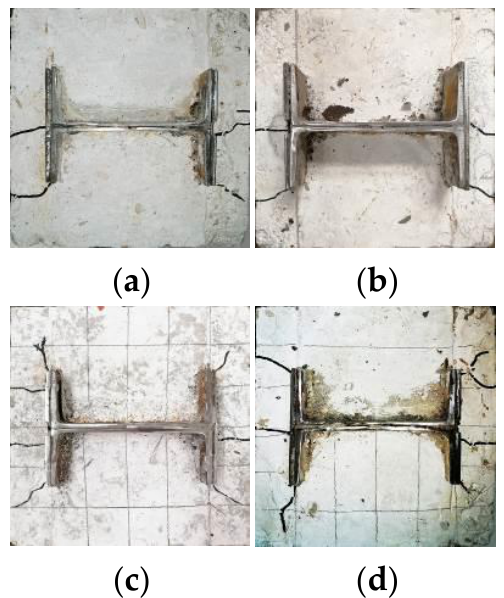
Figure 7. Other cracks morphologies. ( a ) S-SFRAC05. ( b ) S-SFRAC13. ( c ) S-SFRAC08. ( d ) S-